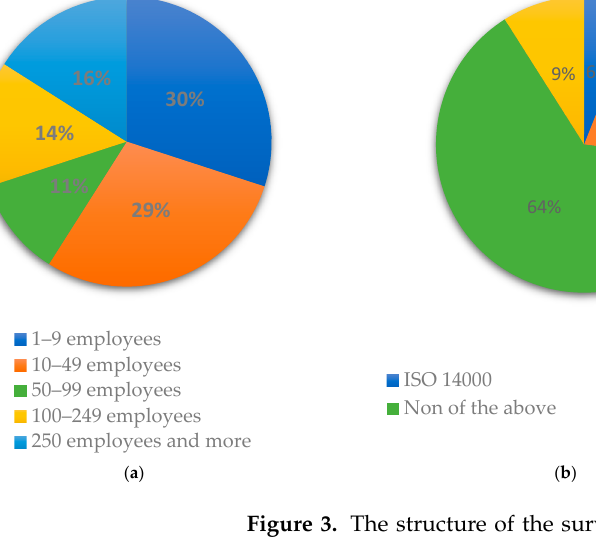
Figure 2. ( a ) High-rise buildings under construction in Sharjah [own materials]. ( b ) High-rise buildings under construction in Sharjah [own materials].